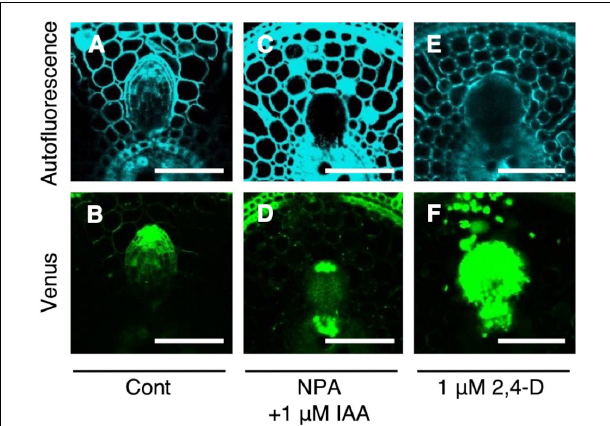
FIGURE 6 | Analysis of auxin signaling distribution in lateral root primordia (LRP) of wild-type (WT) rice treated with auxin and chemical inhibitor. LRP observed in cross-section of crown roots expressing DR5-NLS-3xVENUS in the background of WT in the (A,B) control, (C,D) co-treatment of NPA and IAA, and (E,F) 2,4-D treatment. Autofluorescence and Venus signals are shown. Scale bars = 100 µ m.